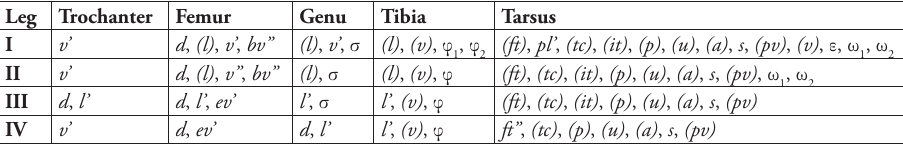
Table 1. Leg setation and solenidia of adult Paraleius leahae sp. n., single prime ( ’ ) indicates setae on anterior and double prime ( ” ) setae on posterior, seta in parenthesis indicates the presence of both setae. Leg Trochanter Femur Genu Tibia